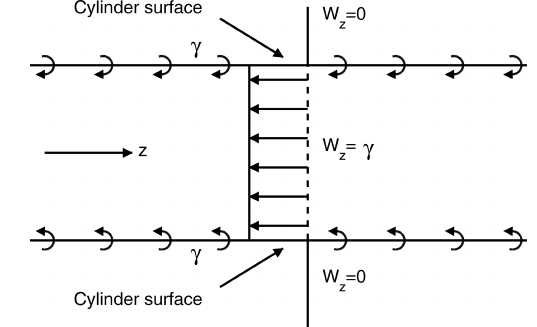
Figure 2. Sketch of velocity field induced by an infinitely long ex- truded surface of tangential vortex density γ